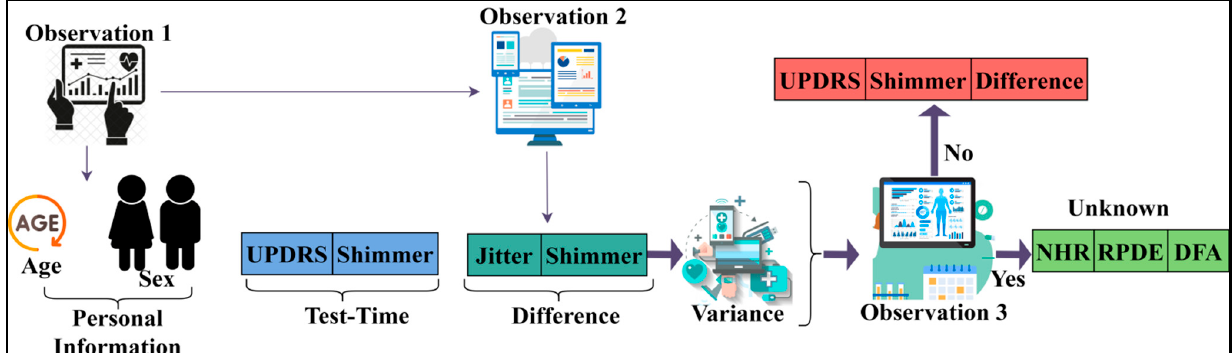
Figure 6. Unknown sequence pattern